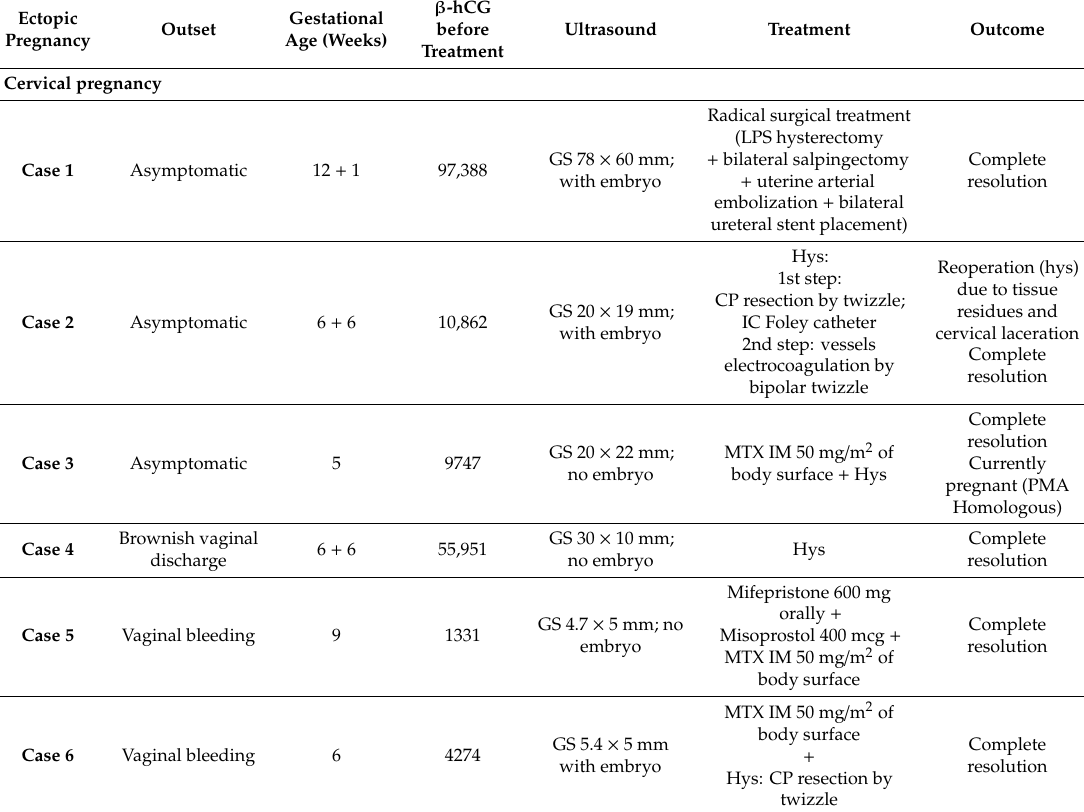
Table 2. Non-tubal ectopic pregnancies: A single center experience. For each subtype of NT-EP are reported clinical presentation, gestational age, basal β -hCG levels, ultrasound findings, treatment details (medical or surgical or medical combined with surgical) and